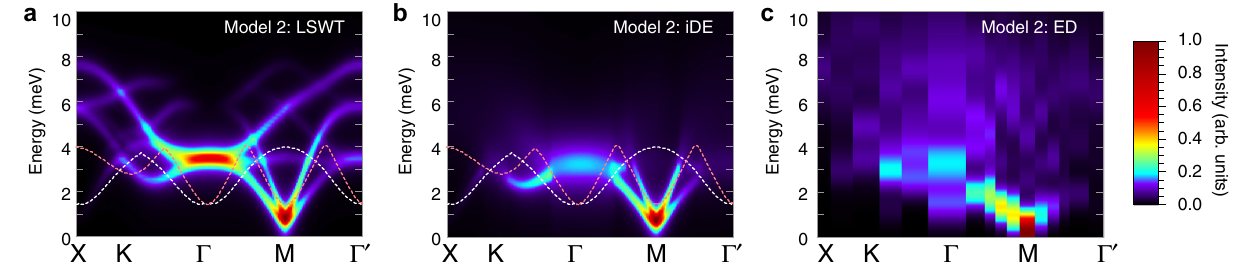
Fig. 6 Effects of two-magnon decays in Ið k ; ω Þ for extended model. Results are shown for Model 2 computed via a LSWT, b self-consistent iDE approach, and c ED. Results in a and b are averaged over the different zigzag domains. The white and pink dashed lines indicate the bottom of the two-magnon ð k Þ for the different zigzag domains. In the iDE results, the effects of two-magnon decays strongly broadens any magnon bands overlapping continuum, E min 2 with the two-magnon